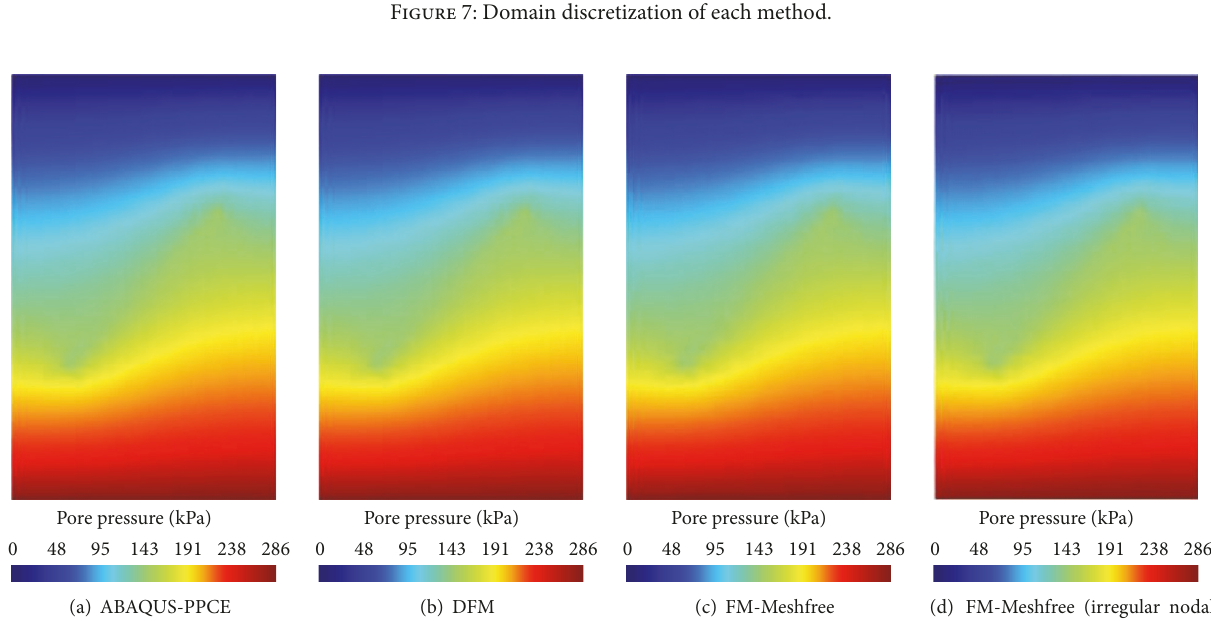
Figure 8: Pore pressure fields obtained by ABAQUS-PPCE and other